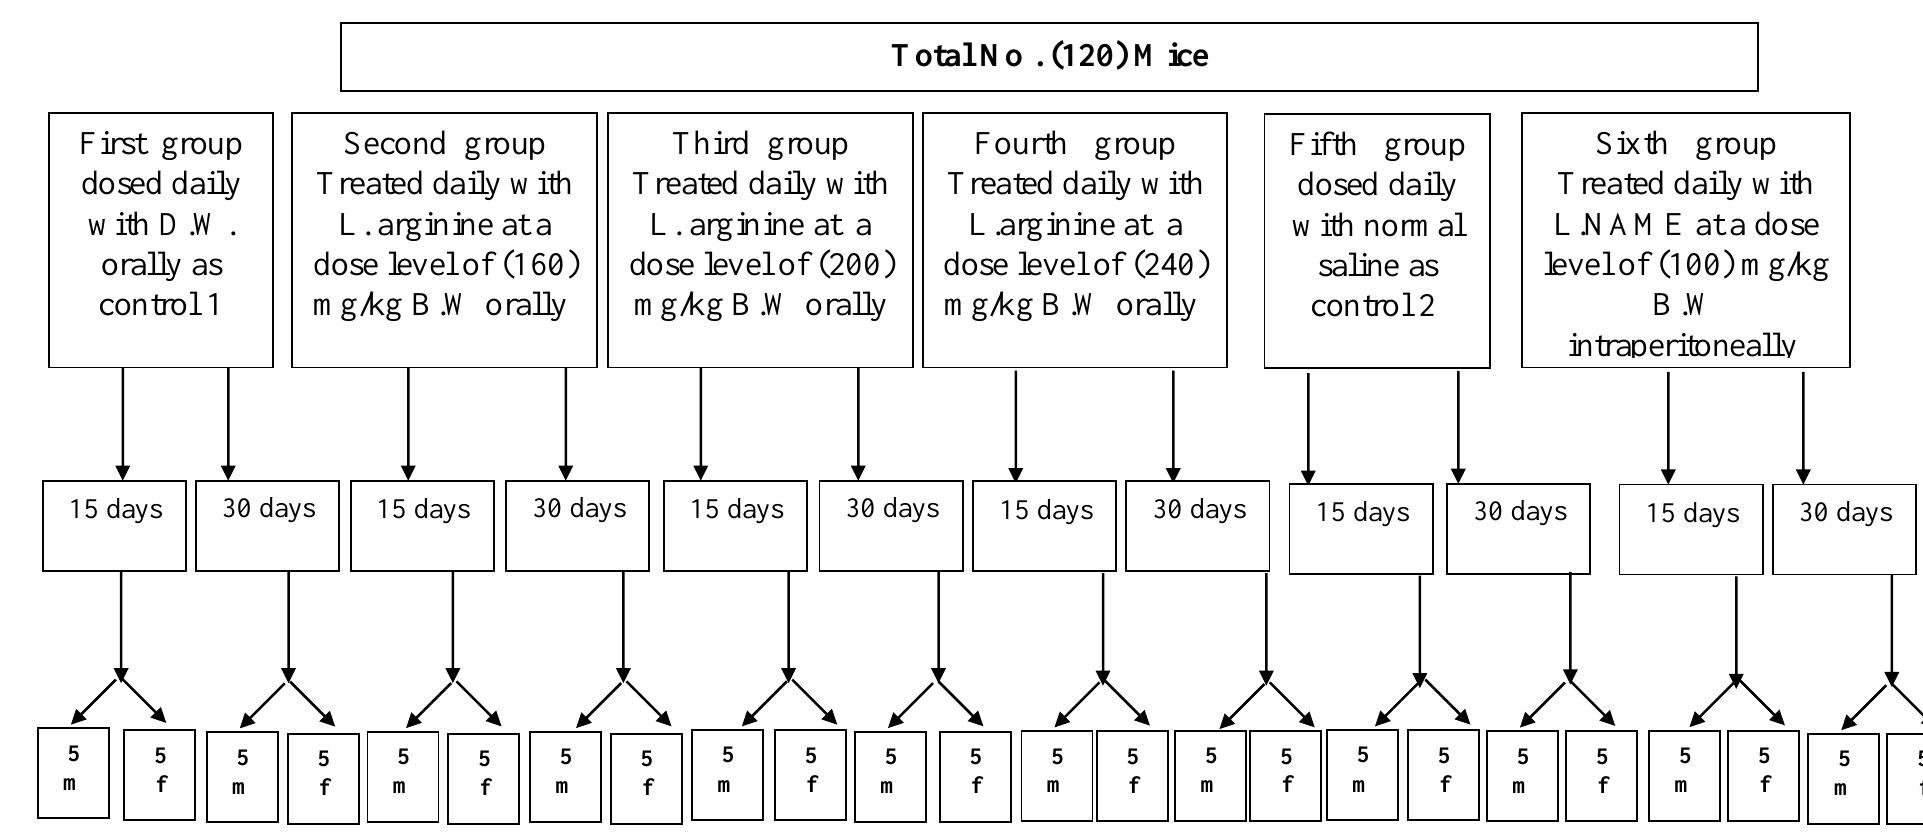
Figure (2): Experimental Design of Formalin